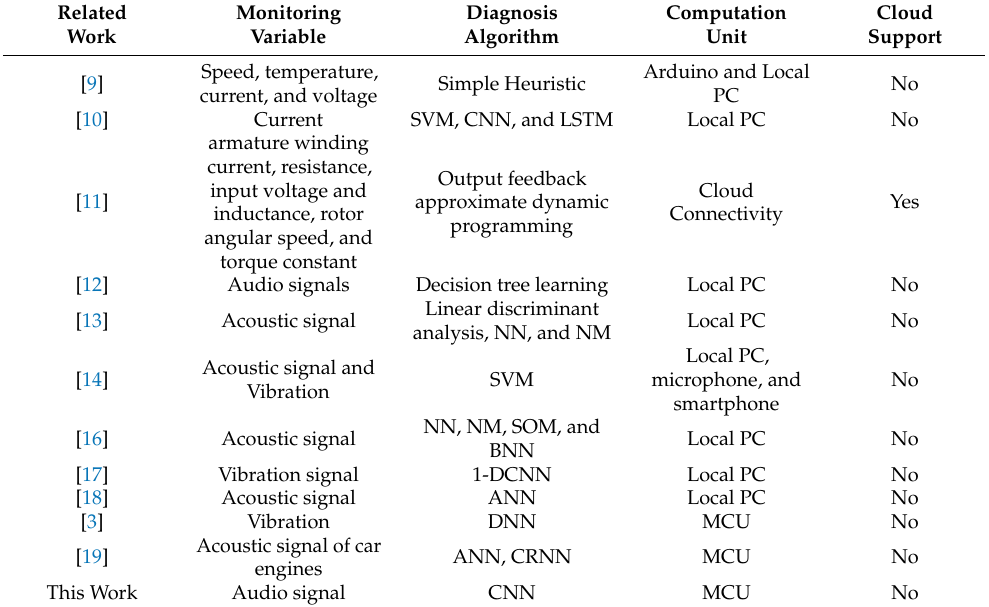
Table 1. Analysis of the methods used for the diagnosis of the DC motor